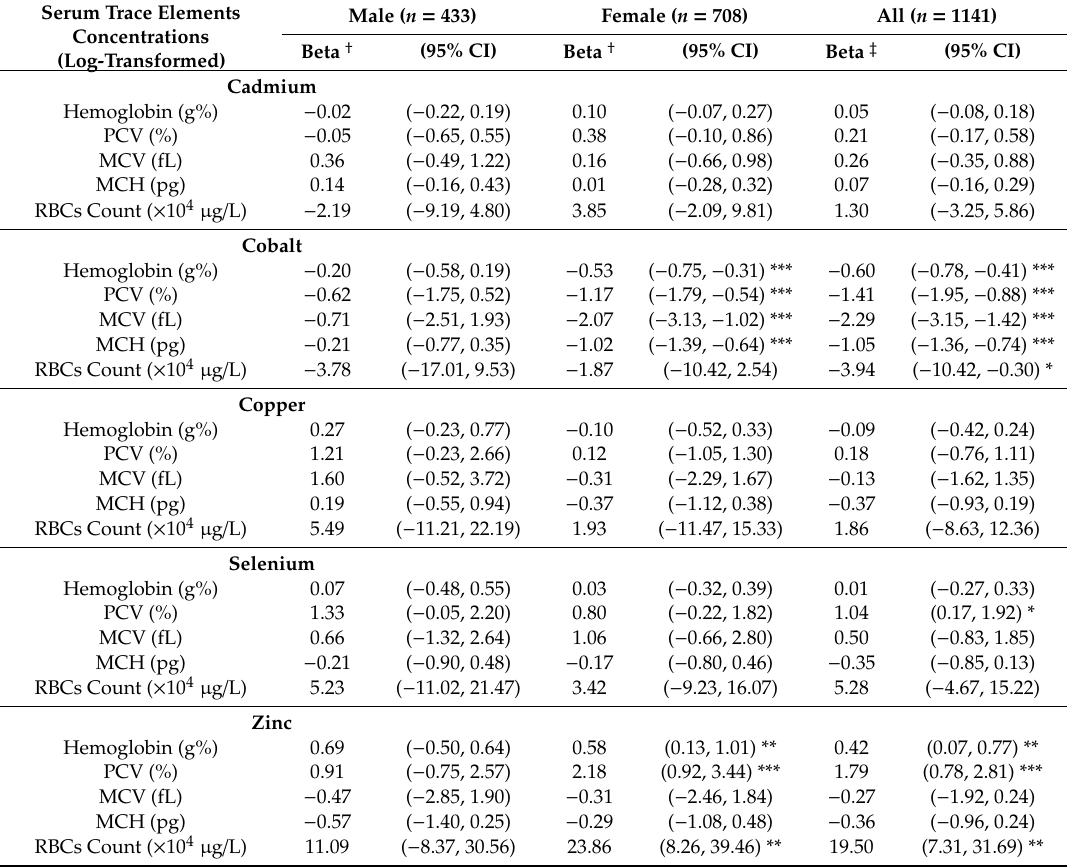
Table 4. Associations between serum trace elements and hematological parameters stratified by sex ( n = 1141). Serum Trace Elements Concentrations